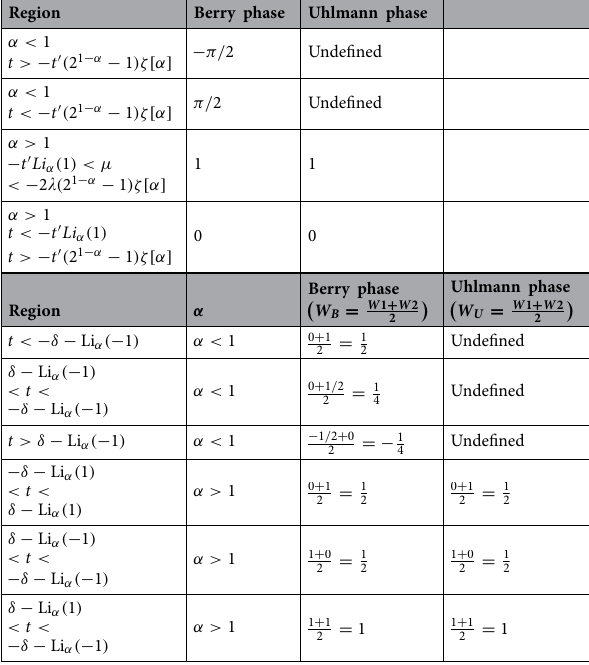
1 . The top and bottom tables =